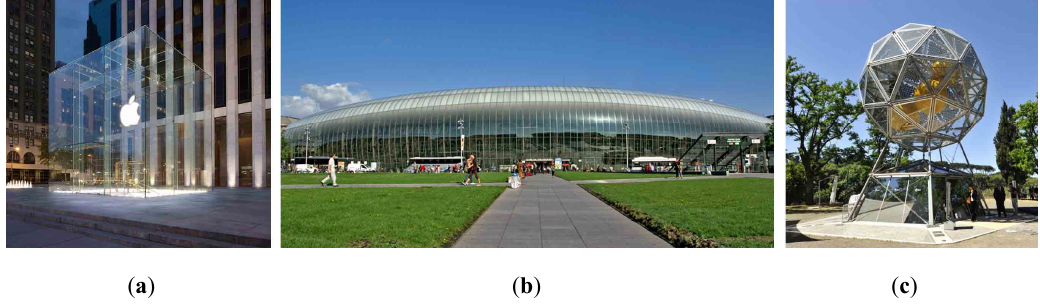
Figure 1. Use of structural glass in contemporary architectures: ( a ) Apple store entrance, New York (USA) [3]; ( b ) Train station, Strasbourg (France) [4]; ( c ) Diamante tirgenerative power station,